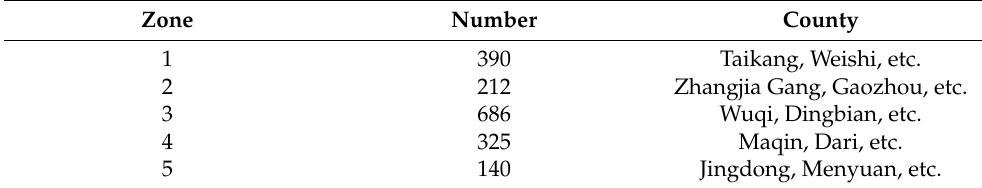
Table 4. County data description in 5